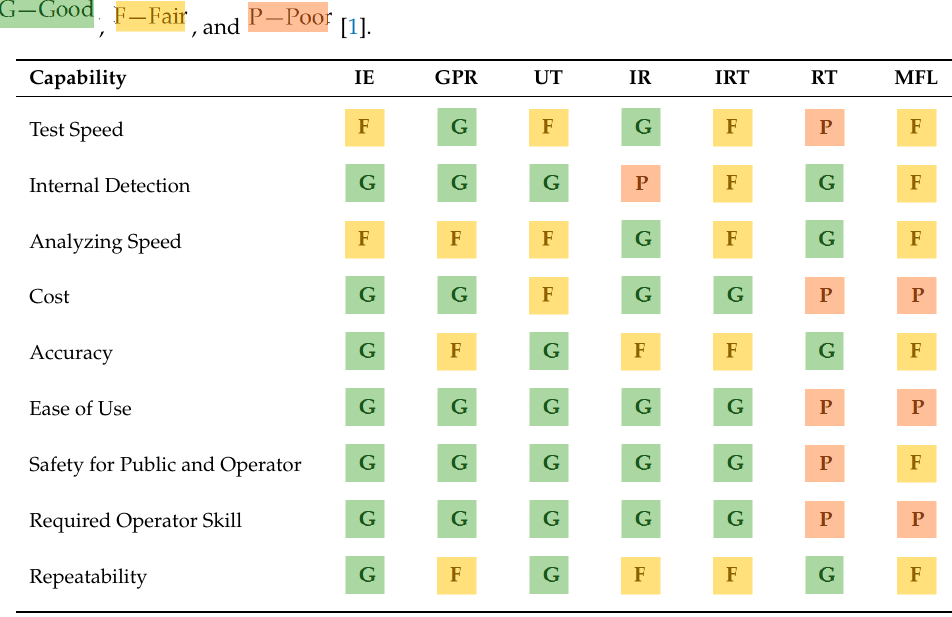
Table 2. Qualitative comparison and preliminary rating of NDT methods for ABC closure joints: G—Good , F—Fair, and P—Poor [1].